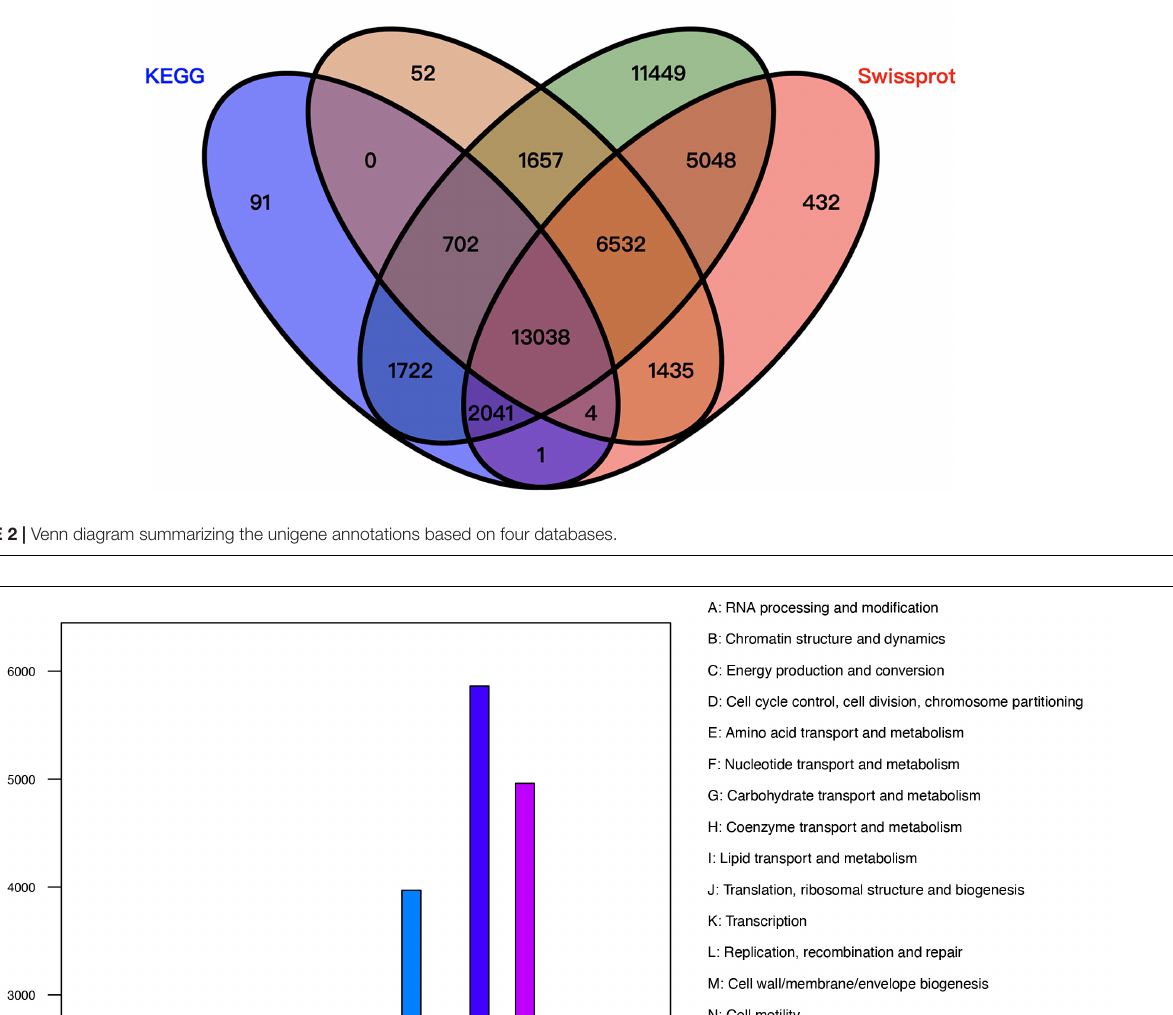
to 1,144, 672, and 136 DEGs, respectively. A total of 128 KEGG pathways were enriched among 1,457 DEGs. The main pathways were “Metabolic pathways” (ko01100), “Biosynthesis